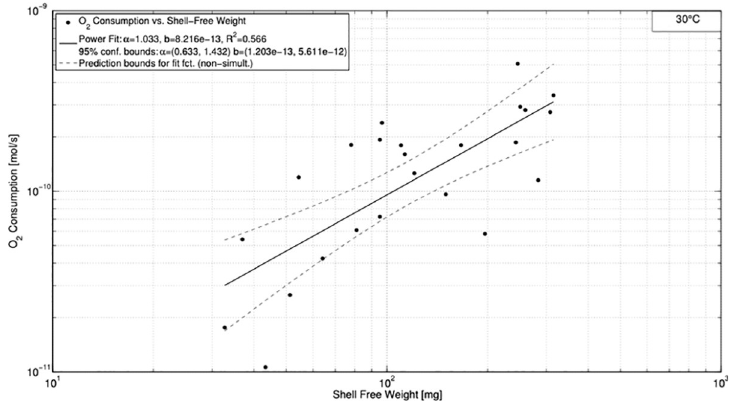
Fig 3. Oxygen consumption vs . shell free weight for